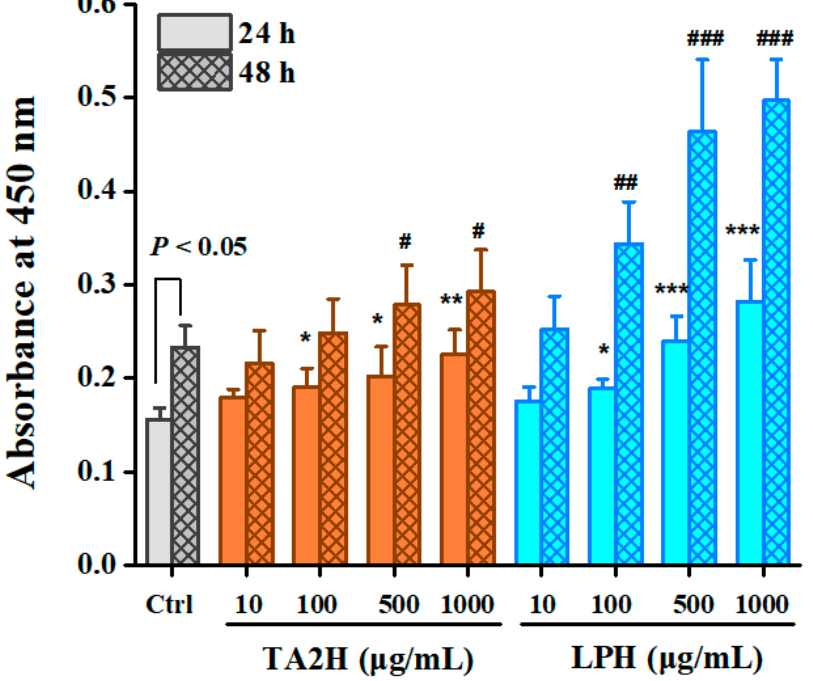
Figure 1. Effects of whey protein hydrolysates (TA2H and LPH) on cell proliferation in preosteoblast cells. MC3T3-E1 cells were serum-starved in 0.1% BSA/ α -MEM for 12 h after seeding on 96-well plates for 24 h and were treated with serum starvation medium containing 0 (control group), 10, 100, 500, and 1000 µ g/mL of TA2H and LPH for 24 or 48 h, prior to adding CCK-8. Data are represented as the mean ± SEM, n = 6. * (or #), ** (or ##), and *** (or ###) indicated p < 0.05, p < 0.01, and p < 0.001, as compared to the control group after 24 (or 48 h).